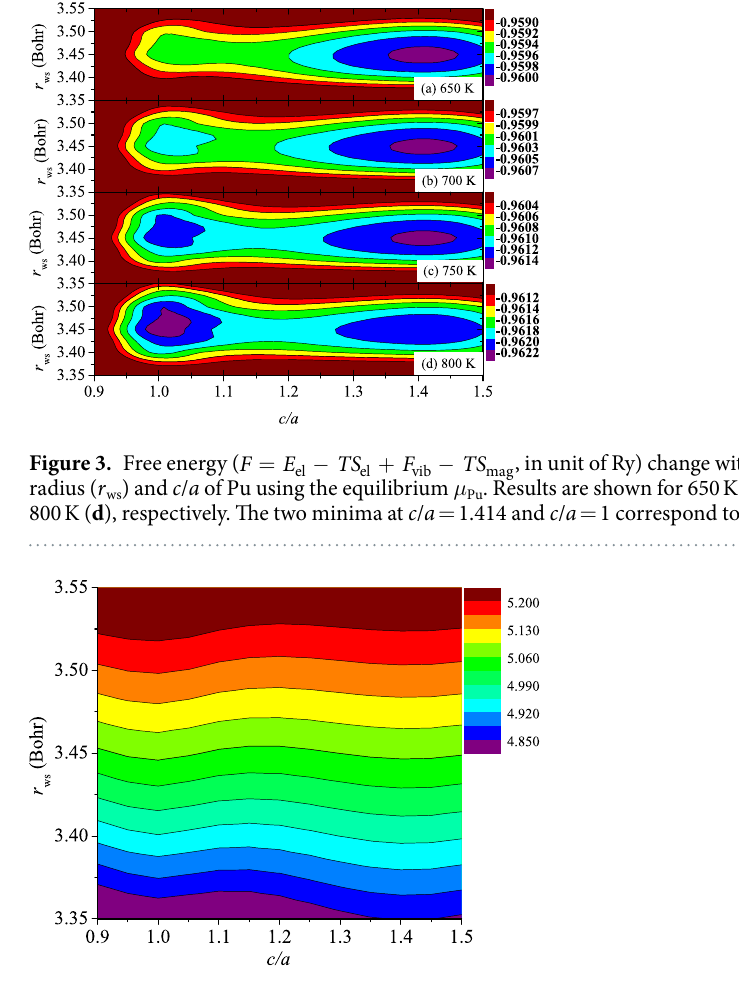
Figure 4. Equilibrium local magnetic moment of Pu ( μ Pu , in unit of μ B ) plotted as a function of the Wigner- Seitz radius ( r ws ) and c / a